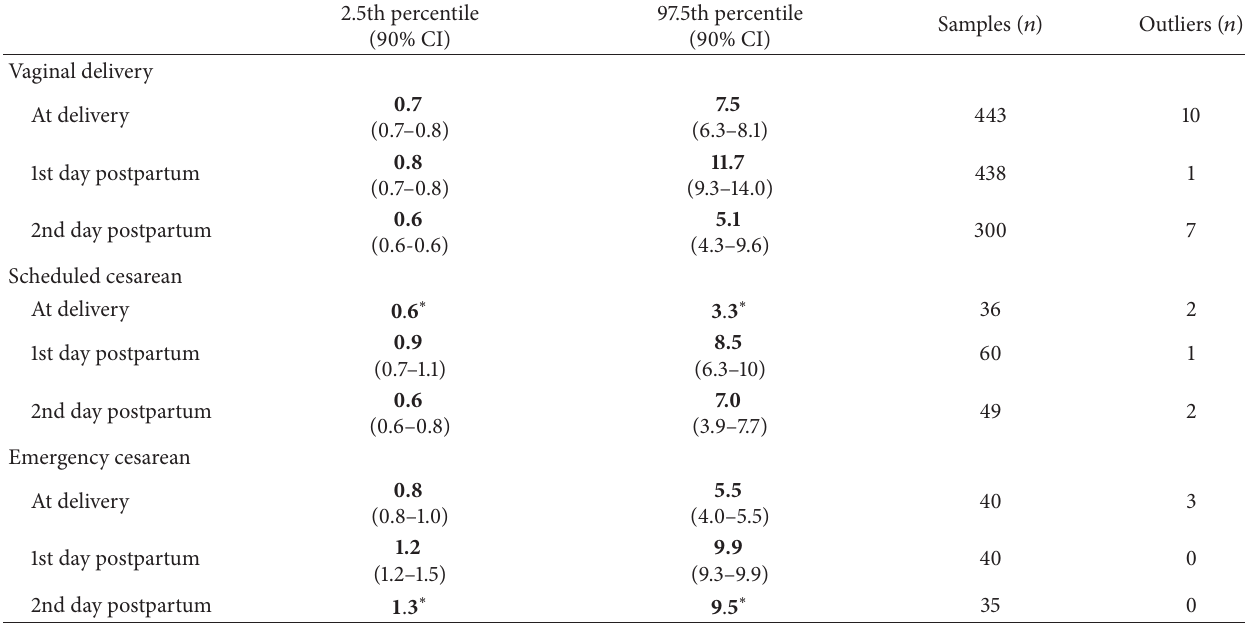
Table 2: The 95% D-dimer reference intervals during delivery and postpartum according to the mode of